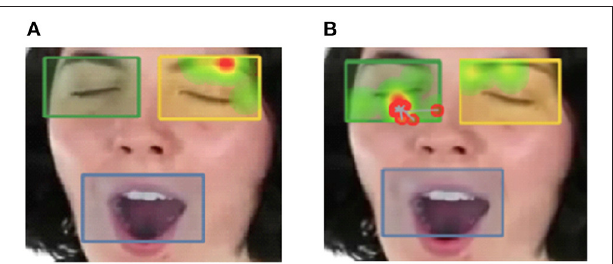
FIGURE 1 | Sample differences of visual fixation points for (A) individuals high in autistic traits, and (B) individuals high in psychopathic traits. Gradients of most attended areas on the heat maps are shown from red to yellow to green. Areas of interest were drawn around the eyes and mouth. Percentage of time that participant eye gaze was fixated within the eye region boxes shown below was positively correlated with tendency to yawn contagiously. FIGURE 2 | Sample